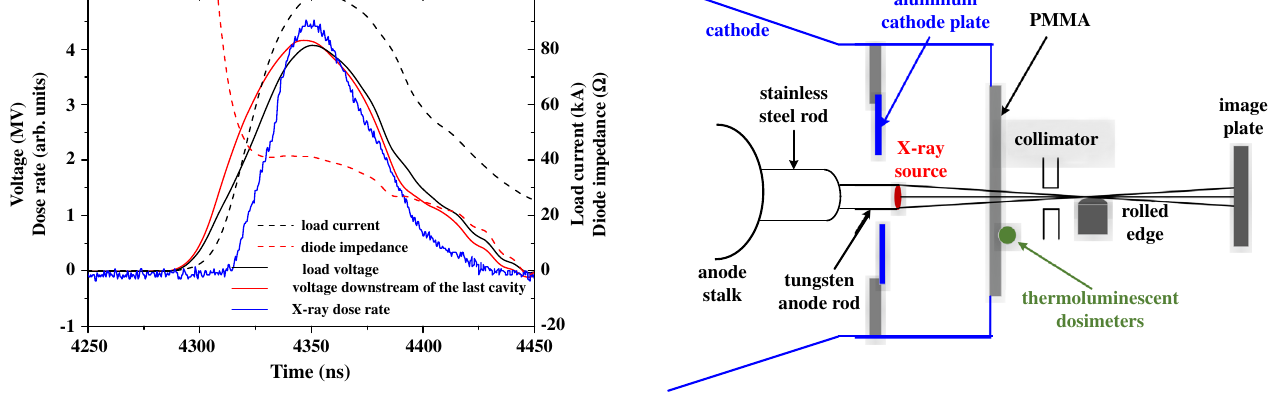
FIG. 14. Schematic of the X-ray dose and spot size measure- ments. There are four LiF TLDs utilized to monitor the X-ray dose for each shot. Those TLDs are sited into a small pillbox and attached to the PMMA endplate.